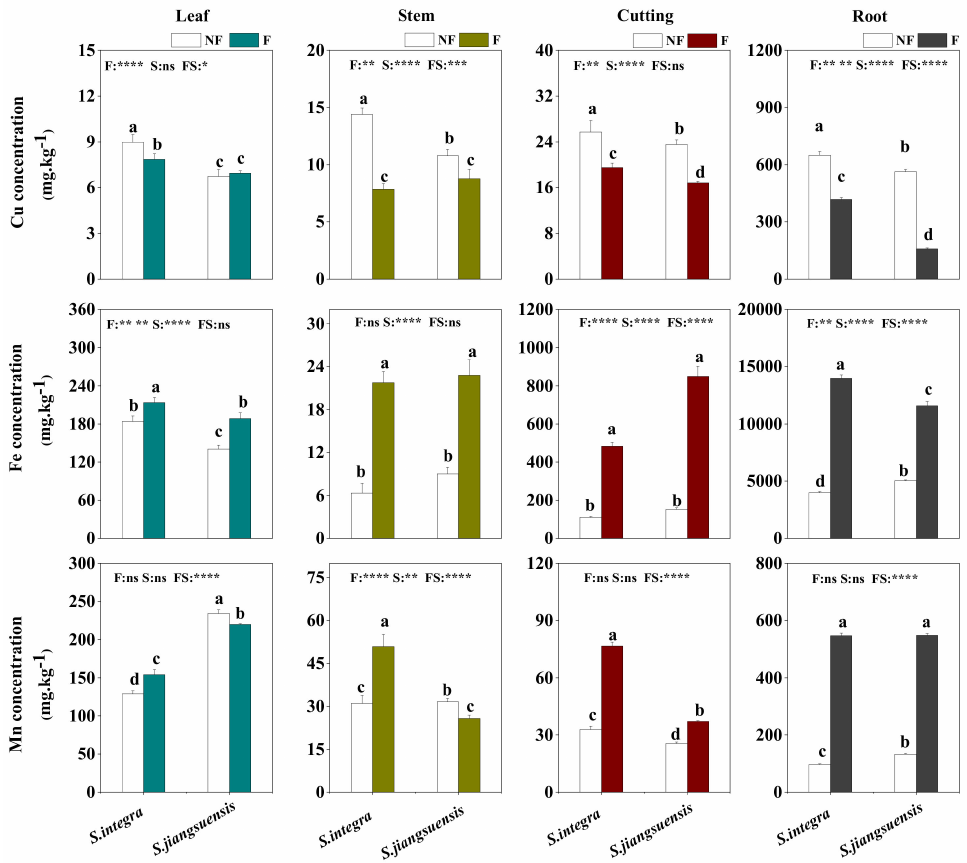
Figure 2. Trace elements (Cu, Fe, Mn in mg · kg − 1 DW) in plant tissues of S. integra and S. jiangsuensis exposed to Cu-contaminated soil under non-flooded and flooded conditions for 90 d. (The data indicate the means ± SD (n = 4). Different letters indicate significant difference among the 4 treatments (2 willow species under non-flooded (NF) and flooded (F) conditions) at the 0.05 level by Fisher’s. The p values of the ANOVA of willow species (S), flooding (F), and their interactions (FS) are also shown. (* p < 0.05; ** p < 0.01; *** p < 0.001; **** p < 0.0001, ns: not